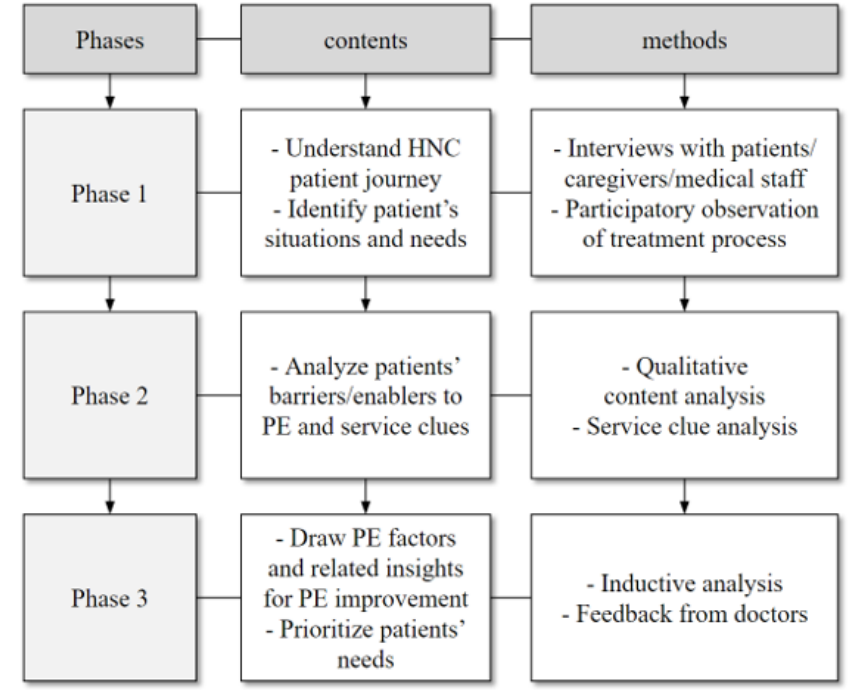
Figure 1. The flow chart of the research process.